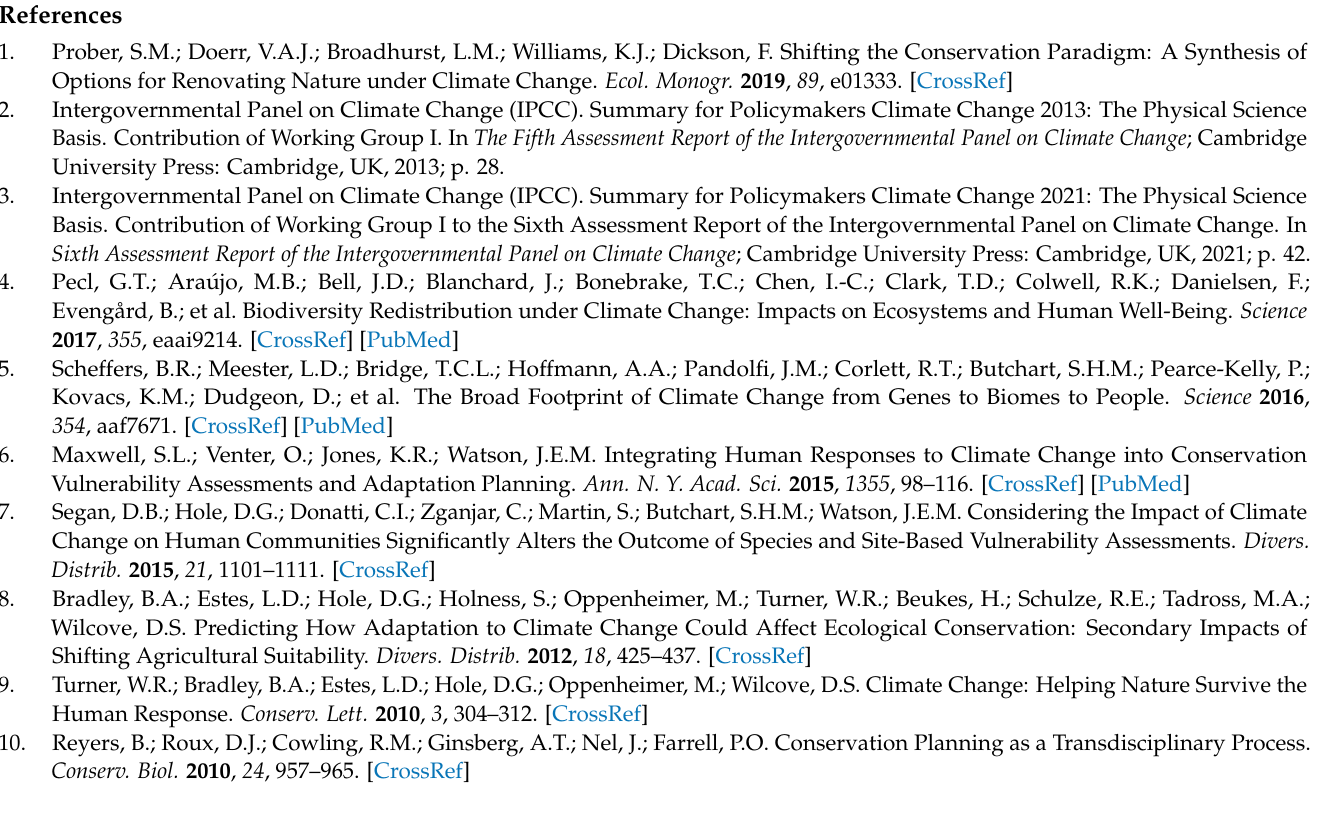
Table S2: Time Frame and Criteria for Rating Conventional and Climate Threats; Table S3: Criteria for Rating Conventional Threats; Table S4: Criteria for Rating Climate